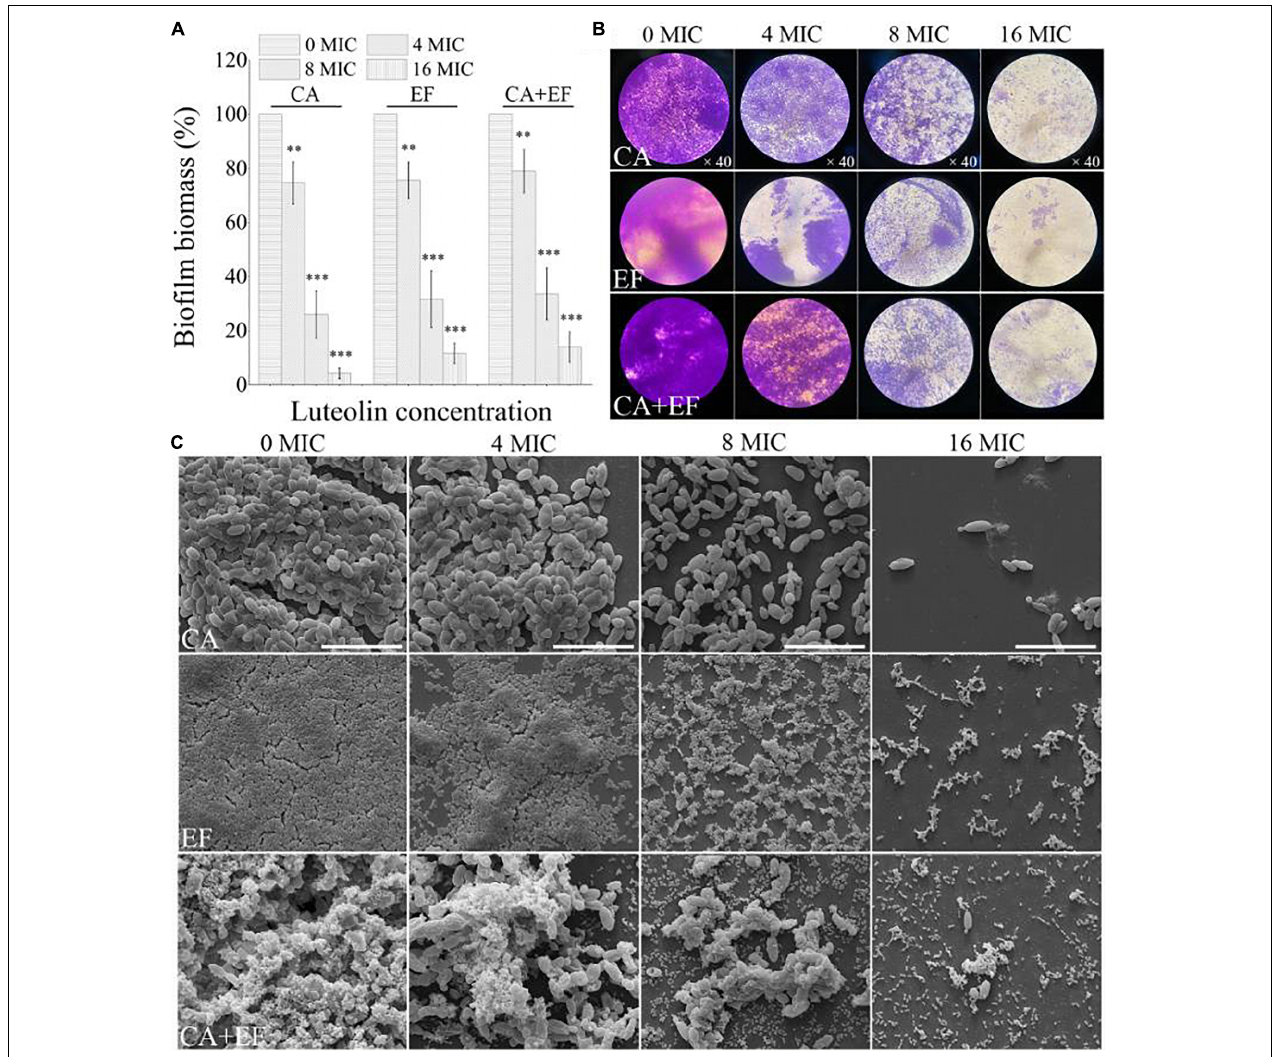
FIGURE 8 | Dispersal effects of various concentrations of luteolin on 72-h-old mature biofilms of C. albicans SC5314 (CA) and E. faecalis 20033 (EF) single and dual species (CA + EF) were assessed using crystal violet staining assay (CVSA) (A) , optical microscope (B) , and field emission scanning electron microscope (FESEM) (C) (scale bars of 20 µ m). Values represent the mean of triplicate measurements. Scale bars represent the standard deviation (SD) ( n = 3). ∗ p < 0.05; ∗∗ p < 0.01; ∗∗∗ p <